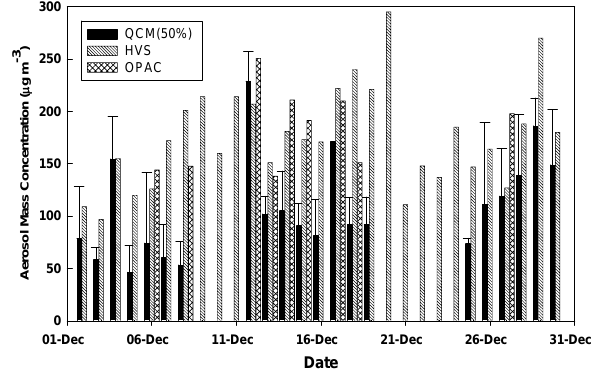
Fig. 7. QCM mass concentration compared with the estimated mass concentration using OPAC mode, and High Volume Sampler (HVS) data.